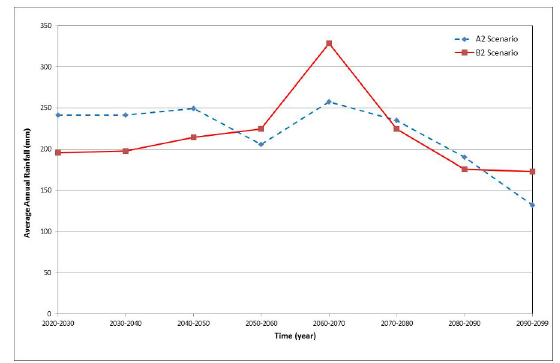
Figure 15. Change of average annual rainfall with time.